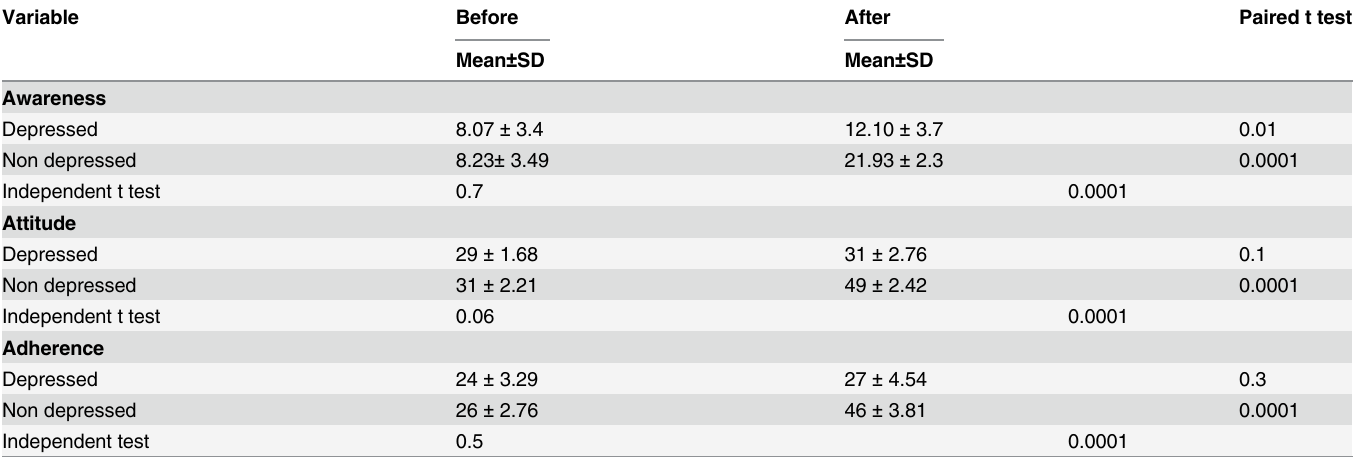
Table 3. Awareness, Attitude, and Adherence to Self-Care Behavior Scores in Depressed and non depressed Patients Before and After the